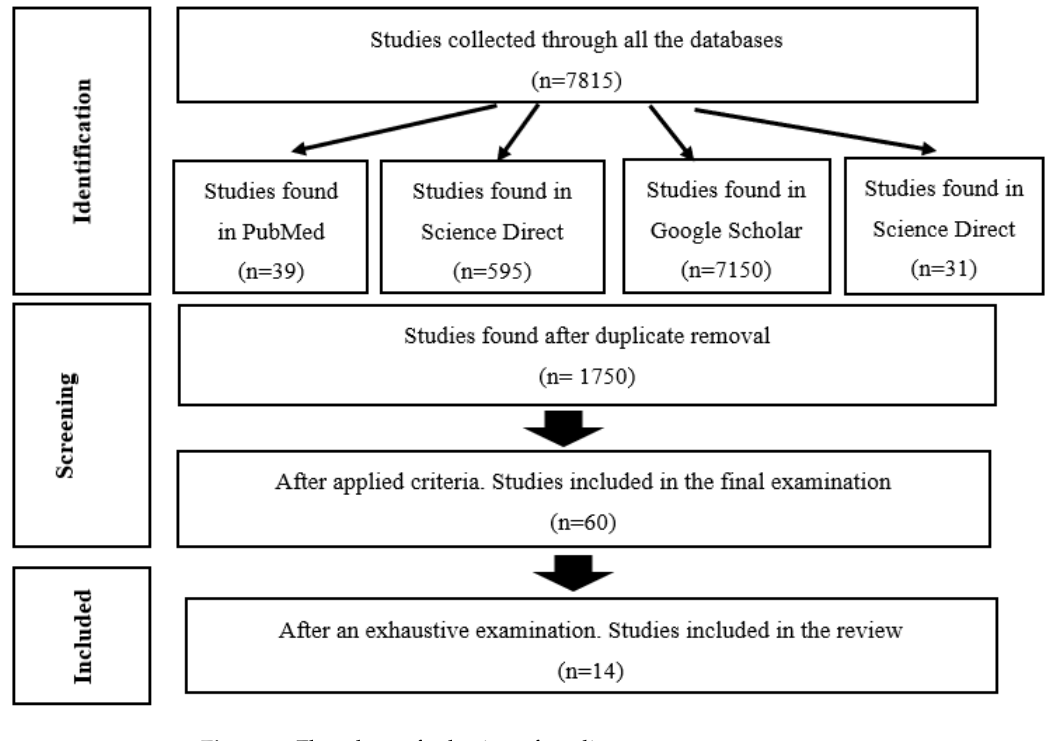
Figure 1. Flowchart of selection of studies.